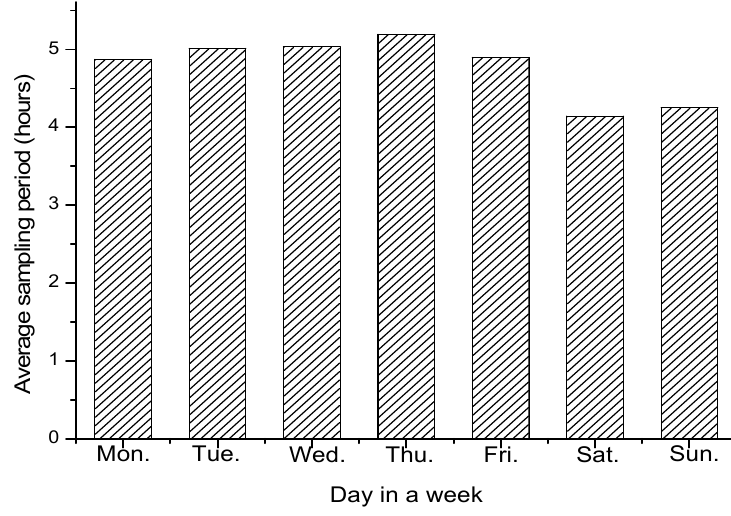
Figure 10. The average sampling period within the day in a week.